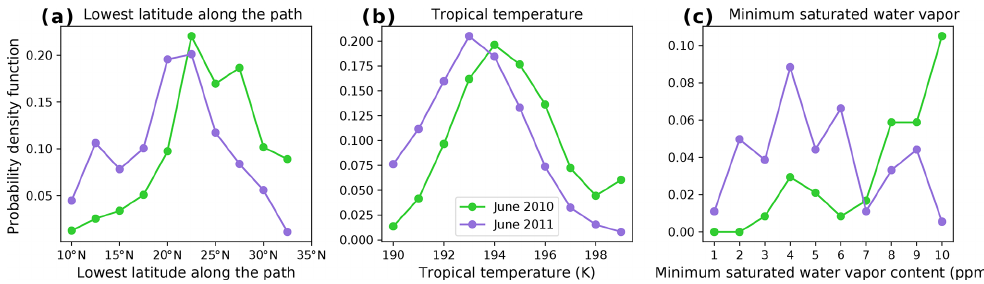
Figure 6. PDF of (a) the lowest latitude along the path in the back trajectory experiments, (b) daily tropical temperature (K) obtained from ERAi (0–20 ◦ N, 70–130 ◦ W), and (c) minimum saturation water vapor mixing ratio (ppmv) in the back trajectory experiment results. Minimum saturation water vapor mixing ratios and lowest latitude are the minimum values along the path after the parcels encounter deep convection in the back trajectory model and prior to being observed by